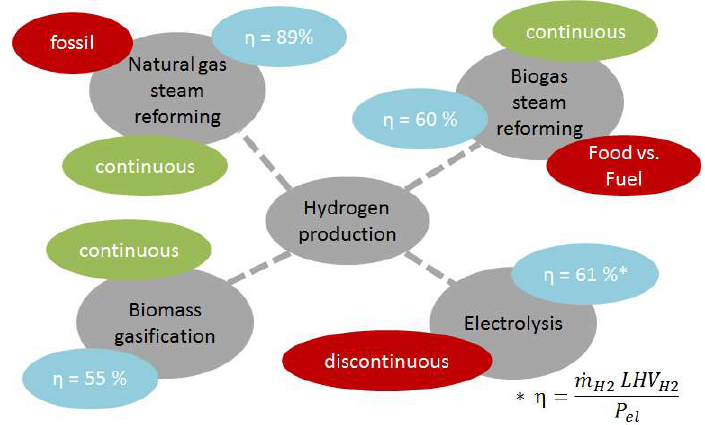
Figure 8. Comparison of different hydrogen production routes in respect to efficiency, hydrogen production and renewability.